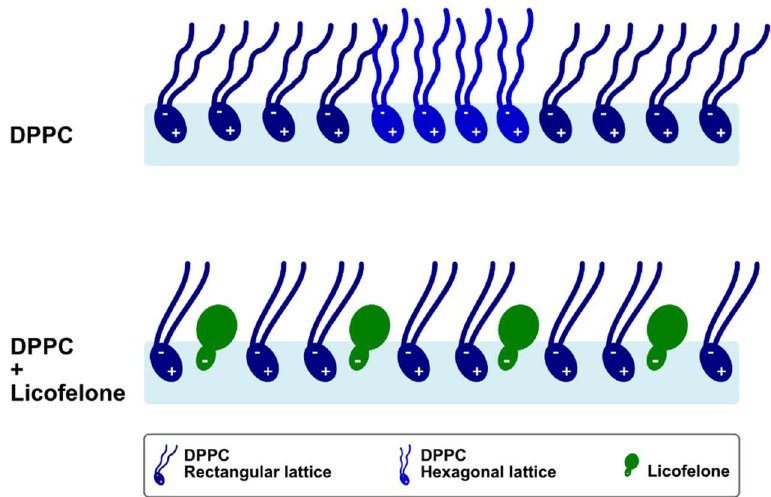
Figure 6. Schematic representation of the licofelone-induced alterations in the DPPC